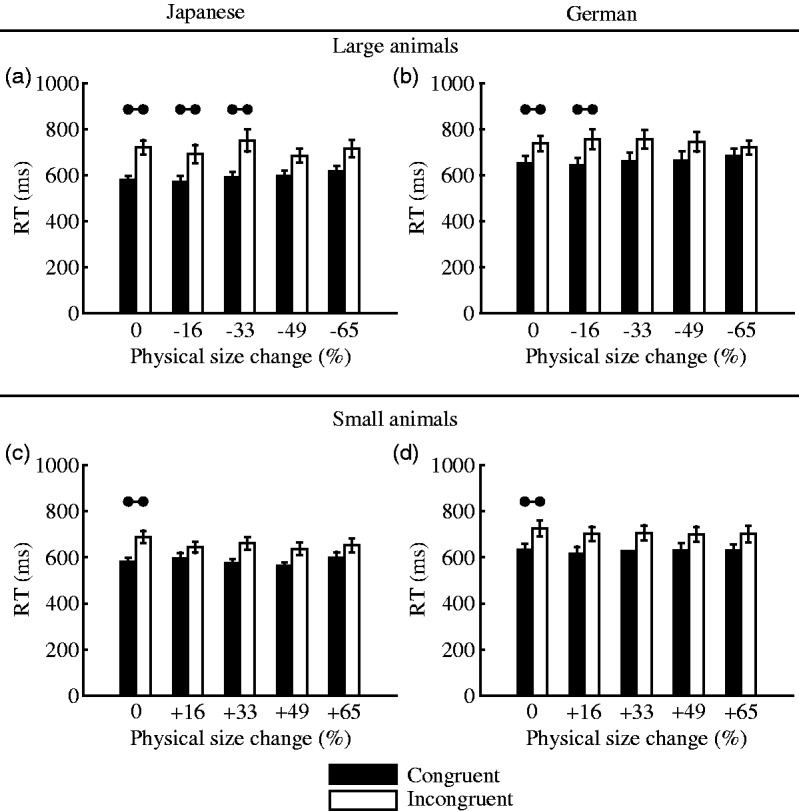
Average RT shown for each experimental condition (Congruent
vs. Incongruent) and the physical size of the visual
stimuli. The figures were drawn using the dataset for (a)
Japanese participants – large animals, (b) German
participants – large animals, (c) Japanese participants –
small animals, and (d) German participants – small
animals. Error bars indicate standard errors. The results
of pairwise comparisons are represented by horizontal bars
(p < .05, Tukey-corrected).RT = response time.